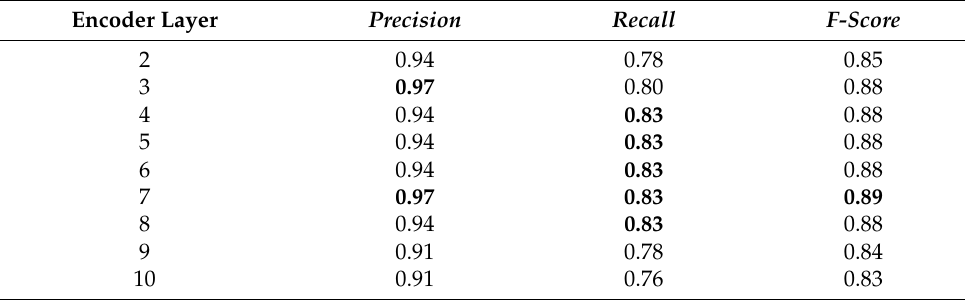
Table 6. The performance of the MTCformer with different encoder